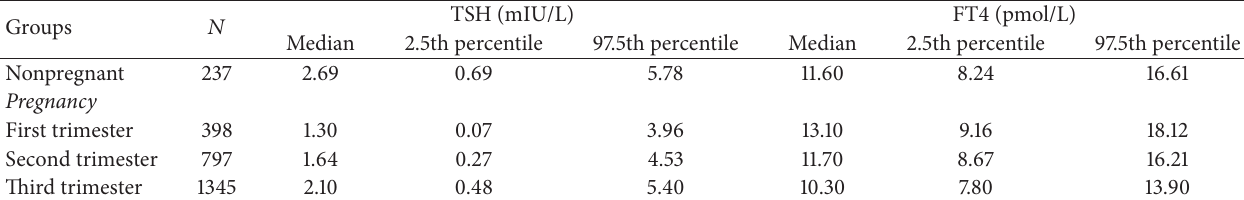
Table 1: Reference intervals for TSH and FT4 in each trimester of pregnancy and in nonpregnant women.